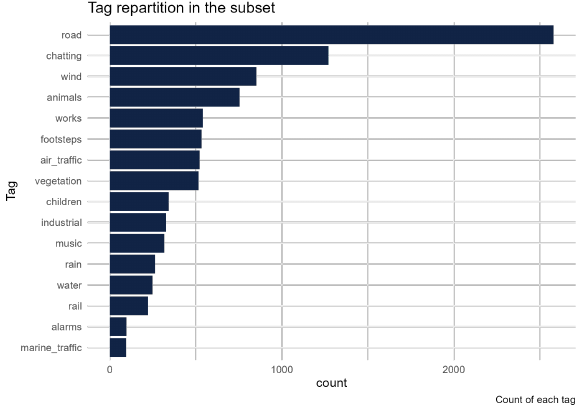
Figure 1. Tag representation in mainland